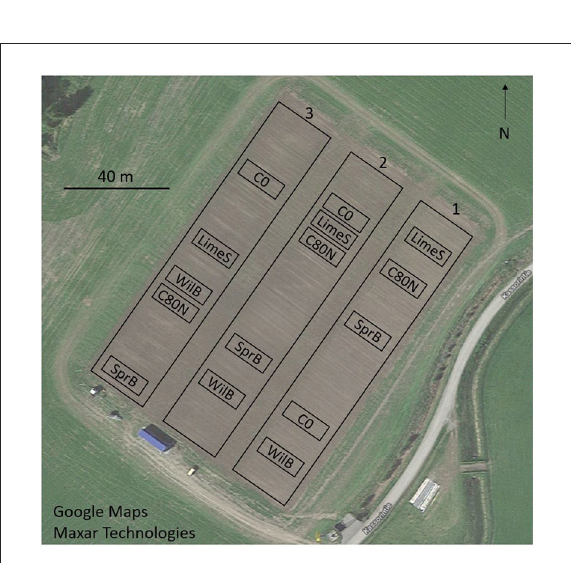
FIGURE2 Experimental set-up with three replicate blocks (1–3) each having five plots, one for each treatment: C0, non-fertilized control; C80N, fertilized control; LimeS, lime-stabilized pulp sludge; SprB, spruce biochar; WilB, willow biochar.